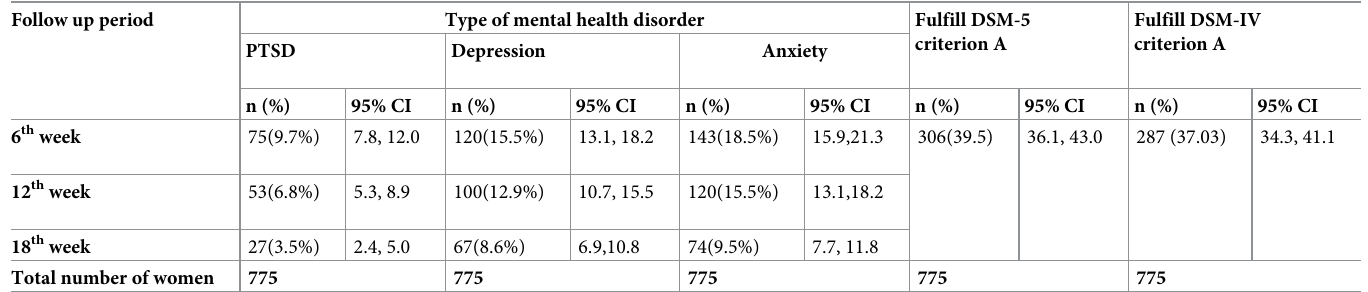
Table 2. Prevalence of depression, anxiety and PTSD among postpartum women in Northwest Ethiopia, 2021. Follow up period